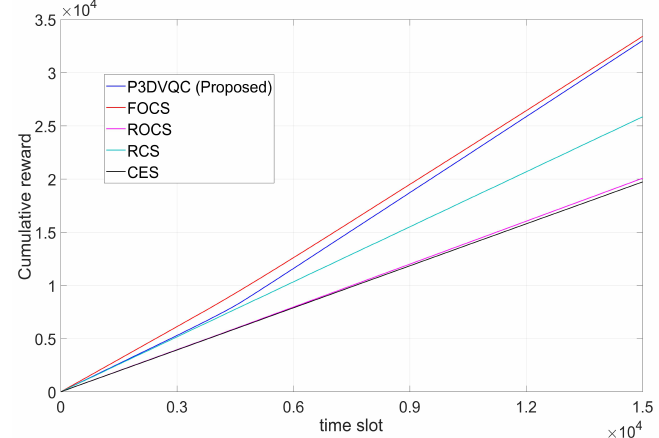
Figure 8. Cumulative